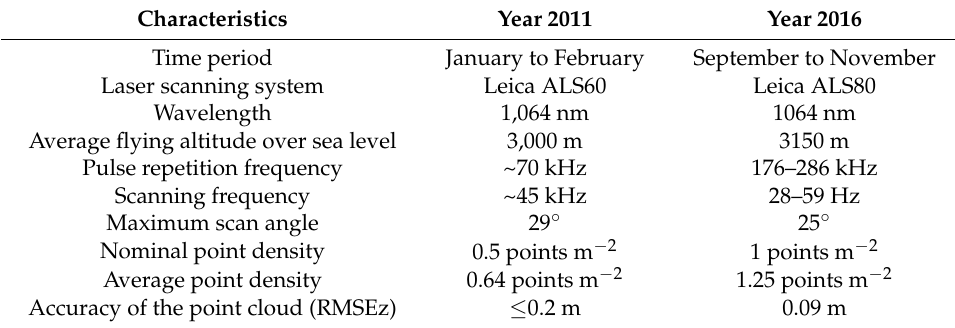
Table 2. Technical specifications of airborne laser scanning (ALS)